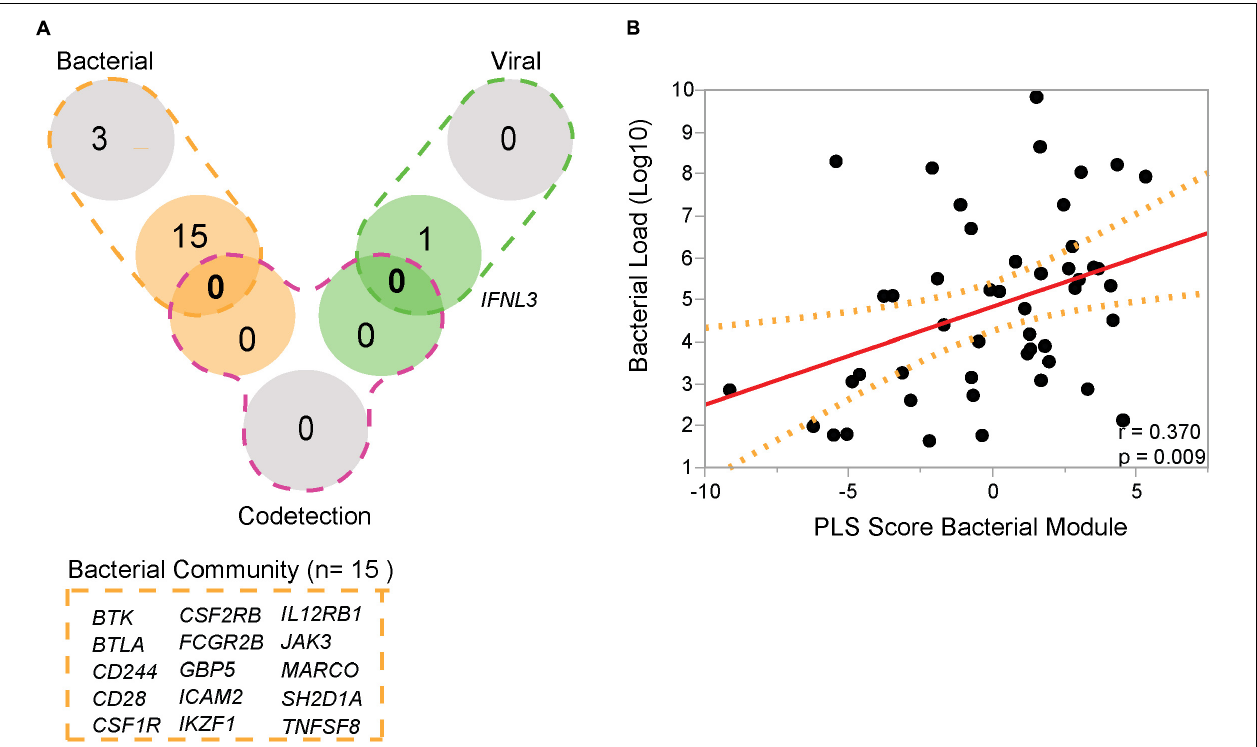
FIGURE 6 | Modules of immune genes differentially expressed in nasopharyngeal aspirates of children with symptomatic ARI. The correlations between DEITs and microbial load in NPAs classified as bacterial (orange) or viral (green) were determined by Spearman ( p < 0.05) and correlation strength was assessed by non-parametric bootstrap. The DEITs with bootstrap values > 50% were subjected to modularity analysis (see Materials and Methods for details). (A) Numbers within the orange or green circles represent genes with similar modularity. Numbers within gray circles represent genes with different modularities (B) Bacterial load in NPAs classified as bacterial and codetection were correlated with Partial Least Square (PLS) scores obtained for the modular communities of differentially expressed genes depicted in A (orange